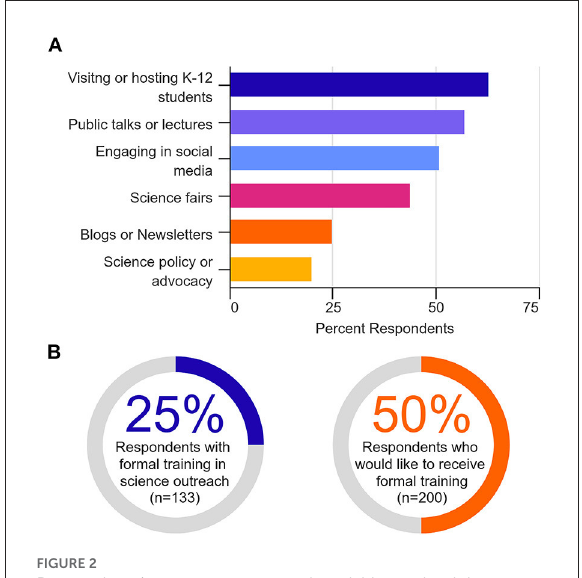
FIGURE2 Respondents’ exposure to outreach activities and